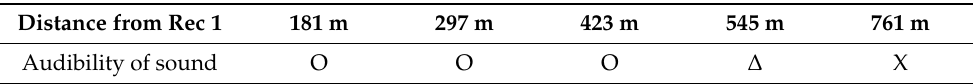
Table 2. Sound from deer whistle was created at different distances from Rec 1. Symbols O, ∆ and X represent the audibility status namely adequately detected, barely detected, and cannot be detected,